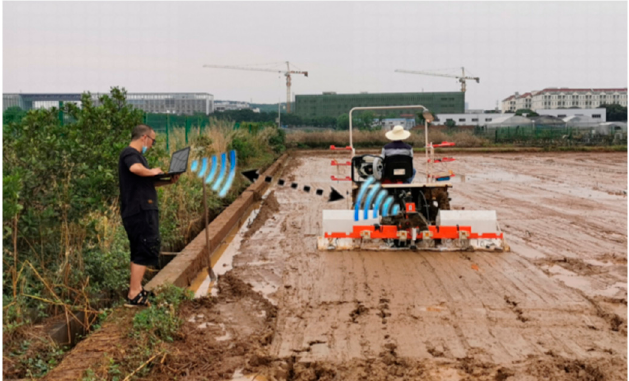
Figure 13. Wireless measurement system.